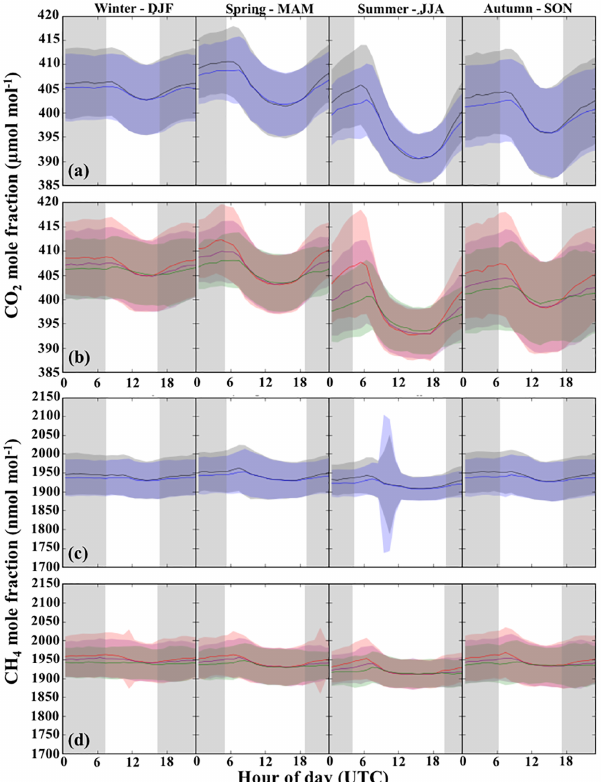
Figure 9. Overview of average diurnal concentration gradients in CO 2 at (a) RGL and (b) TAC as well as CH 4 at (c) RGL and (d) TAC from 23 January 2012 to 1 October 2015. Lines are the median of the entire data period and shaded areas represent the stan- dard deviation (1 σ) . Black and blue data correspond to the 45 and 90ma.g.l. inlet at RGL, respectively, and red, purple and green cor- respond to the 54, 100 and 185ma.g.l. inlets at TAC. Shaded grey areas represent mean seasonal night-time based on the sites’ latitude and longitude. Data shown are in